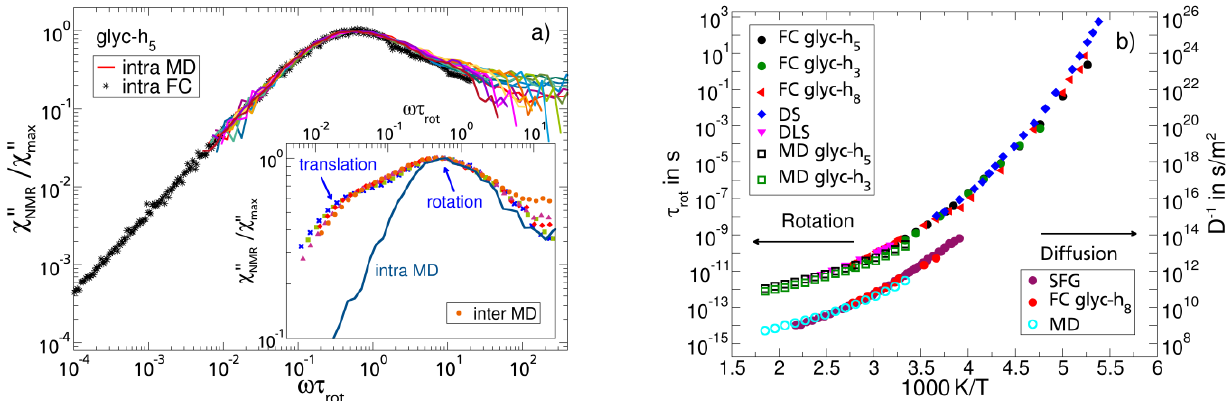
Figure 3. ( a ) Master curves of the intramolecular FC susceptibility χ ’’ intra of glycerol-h 5 as a function of the reduced frequency ωτ rot [72] (black circles) together with the results from MD simulations (coloured lines) [36]. Data are scaled by the maximum values χ ’’ max . Inset: simulation results for the intra- and intermolecular relaxation contributions on a reduced frequency scale. The bimodal structure, reflecting translational and rotational dynamics, is well recognized in the intermolecular part. ( b ) Rotational correlation times τ rot of glycerol as obtained from NMR [36] and other techniques (DS [1] (blue diamonds), DLS [81] (magenta triangles), and MD simulations [36]) together with inverse self-diffusion coefficients D − 1 from static field gradient diffusometry [82] (SFG, purple circles), FC relaxometry on glycerol-h 8 [50], and MD simulations [36].